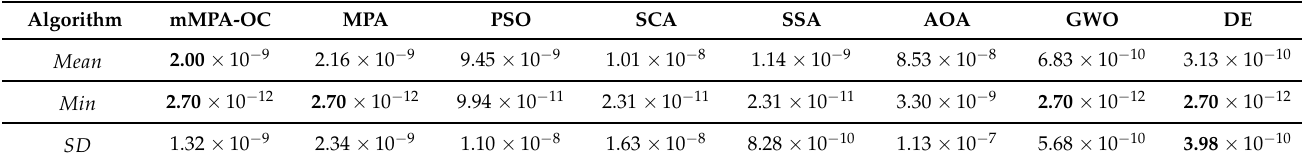
Table 22. Comparison results between mMPA-OC and the other seven meta-heuristics on the gear train design